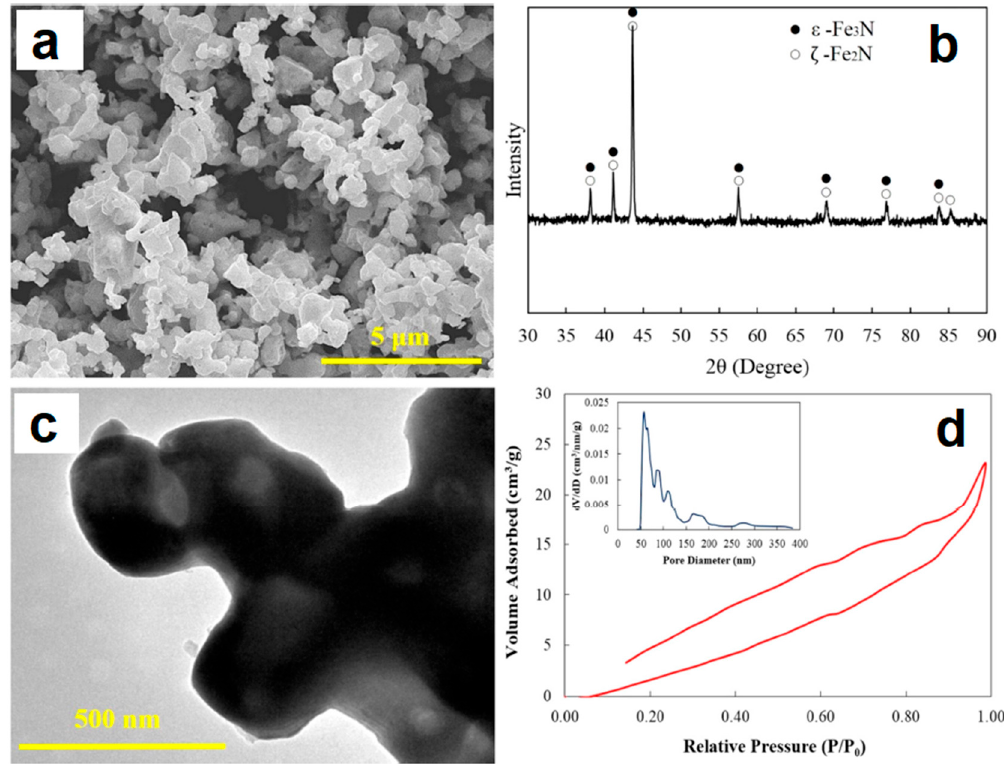
Figure 15. Morphology ( a ), X-ray diffraction (XRD) pattern ( b ), structure in the transmission